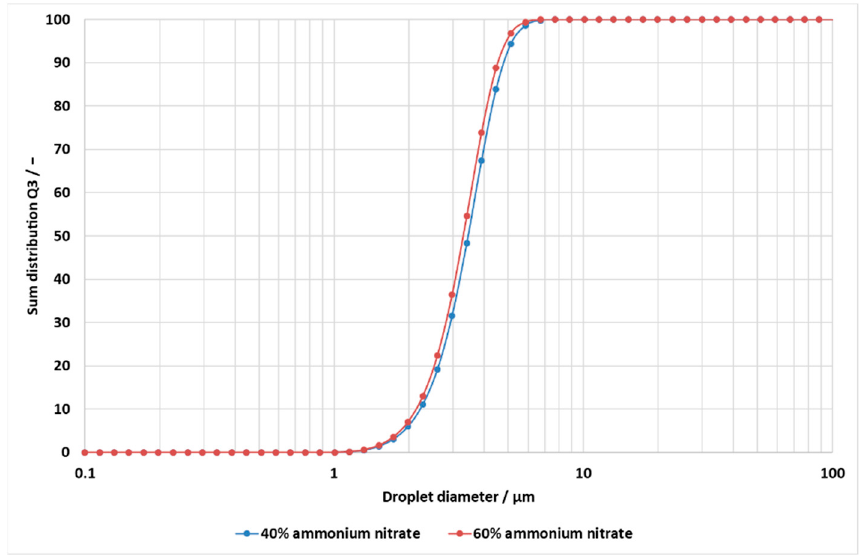
Figure 3. Droplet size distributions of two inner emulsions containing 40% ammonium nitrate and 60% ammonium nitrate, respectively, in the inner water